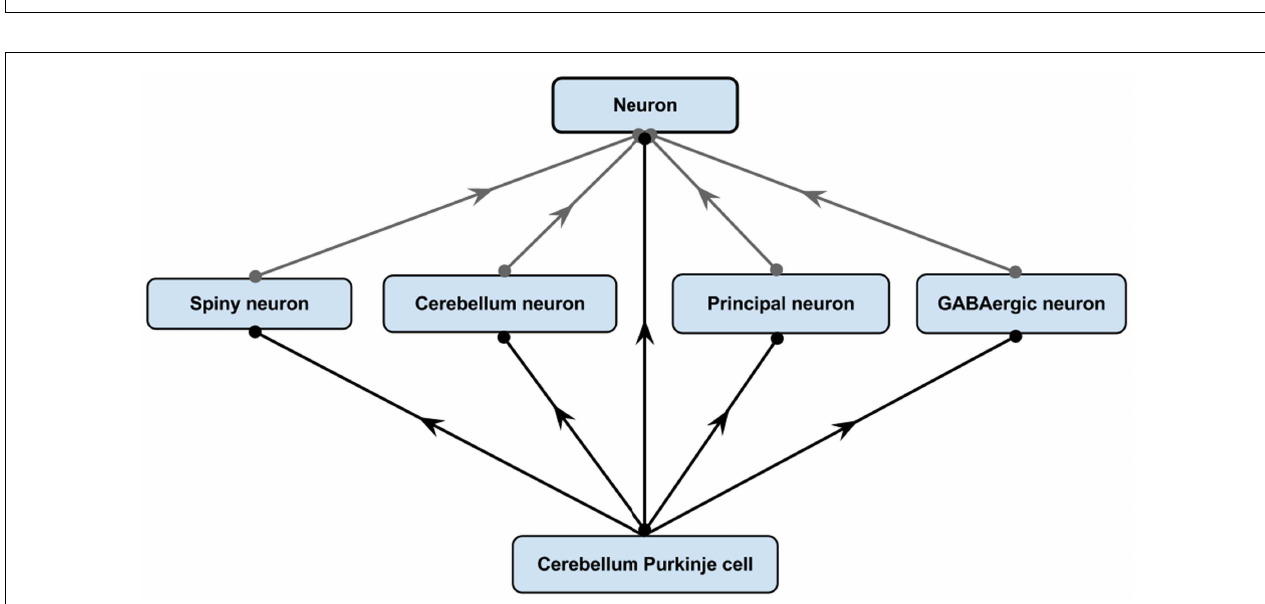
FIGURE 5 |Typical NIFSTD restrictions asserted for various neuron types.